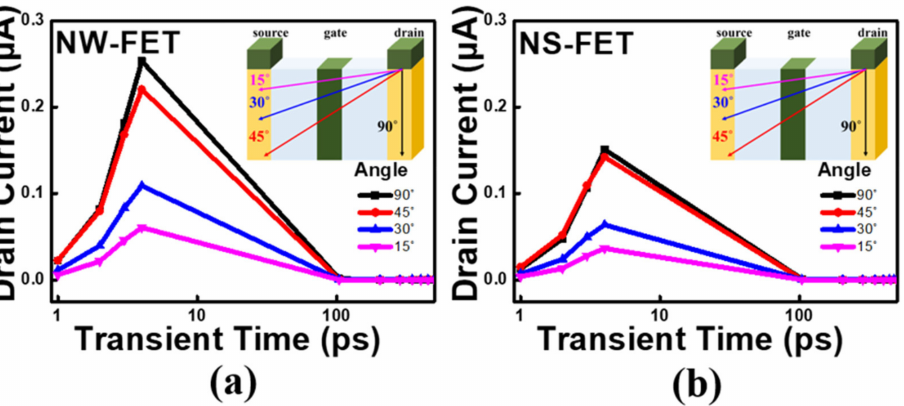
Figure 3. Change in drain current as the particle strikes the drain and moves to the source in the ( a ) NW-FET; ( b )